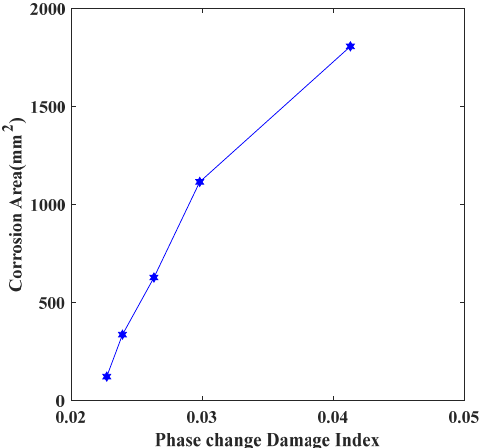
Figure 17. Phase change damage index versus corrosion area.